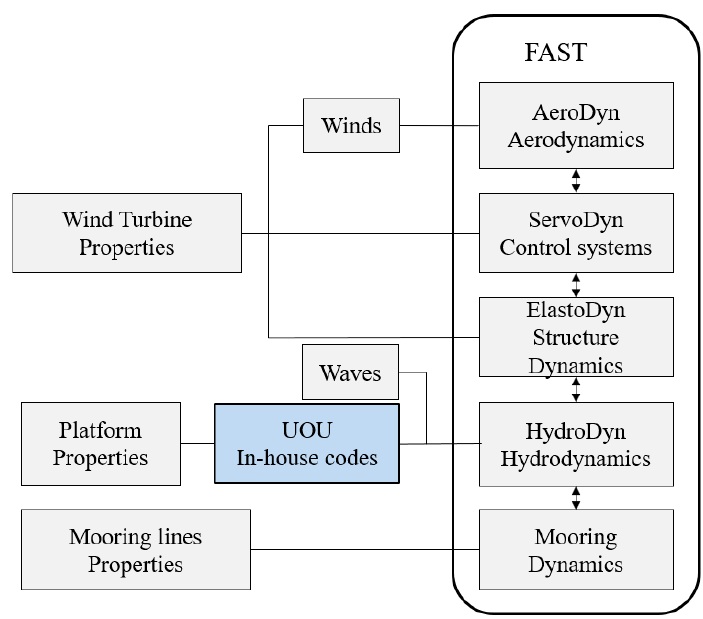
Figure 2. Model tests of the 5 MW semi-submersible platform model in the water tank of Ulsan University (UOU).